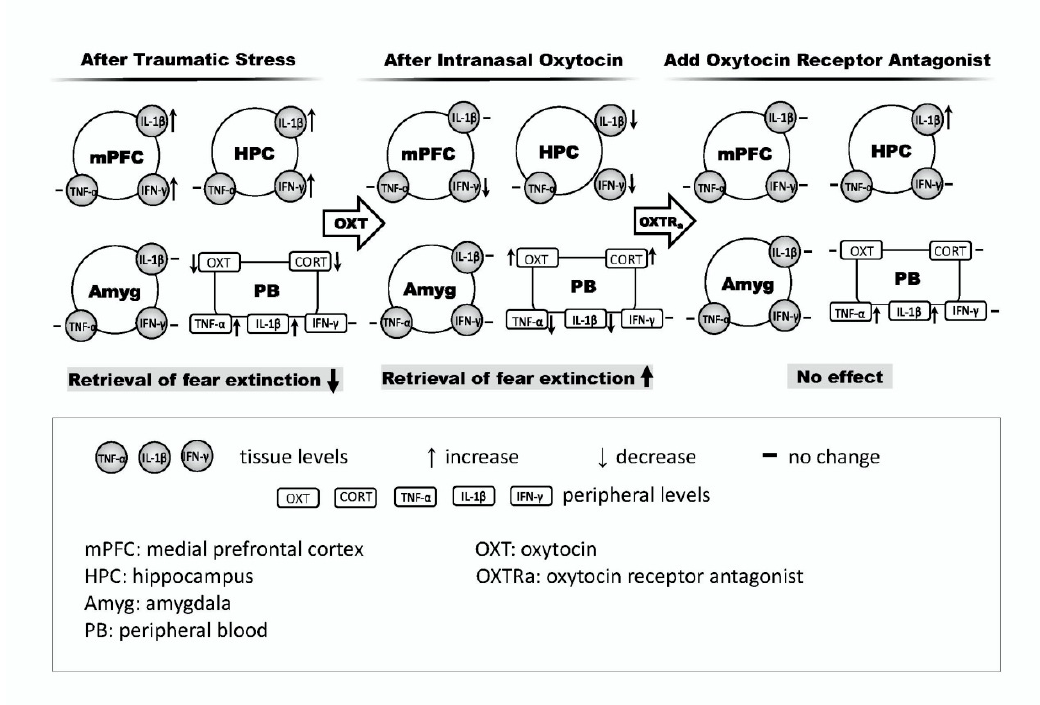
Figure 7. Hypothetical contributions of proinflammatory cytokines in fear circuit areas/peripheral blood on retrieval profiles of fear extinction after traumatic stress ( left panel ), intranasal oxytocin ( middle panel ), and oxytocin receptor antagonist ( right panel ).